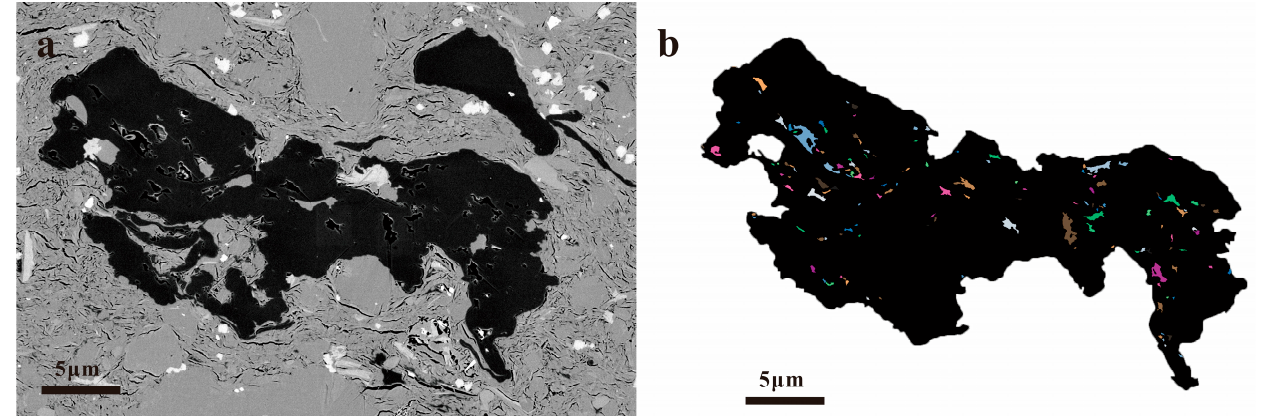
Figure 3. Original ( a ) and colorized ( b ) images of organic pores in sample SK1-S-1 using PCAS software processing.